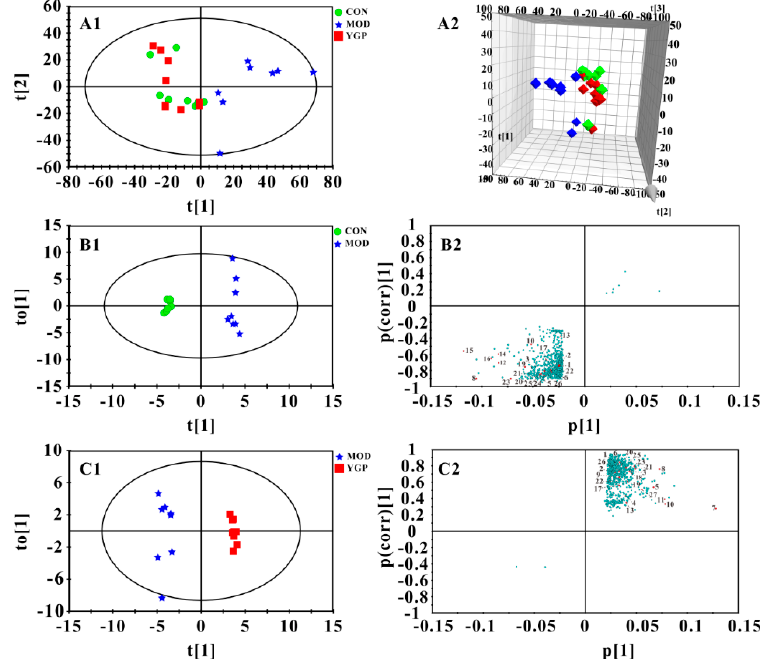
Figure 4. Results of multivariate statistical analysis. Principle component analysis (PCA) score plot and 3D-PCA score plot among CON, MOD, and YGP groups ( A1 , A2 , R 2 X = 0.856, Q 2 = 0.520). Orthogonal partial least squares discriminant analysis (OPLS-DA) score plot and S -plot between CON and MOD groups ( B1 , B2 , R 2 X = 0.842, R 2 Y = 0.993, Q 2 = 0.840, p -value of CV-ANOVA = 0.0298); OPLS-DA score plot and S -plot between MOD and YGP groups ( C1 , C2 , R 2 X = 0.683, R 2 Y = 0.987, Q 2 = 0.714, p -value of CV-ANOVA = 0.0370). The greater the distance of the red dots in S -plots from the origin, the greater the contribution to the grouping. Variables labeled with red dots could be considered as differential metabolites ( B2 , C2 ) and the labels next to red dots correspond to the numbers of metabolites in Table S1. All the points of the important variable values (VIP) < 1 in the S -plots were removed, leaving only the variables with VIP > 1.